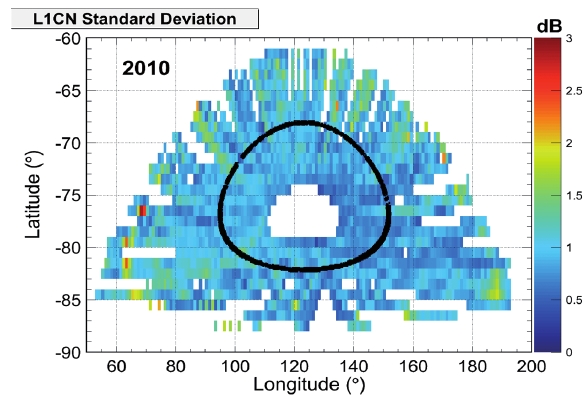
Figure 6. Map of the L1C/N SD in geographic coordinates for 2010. The black curve represents the IPP of the satellite signals with ele- vation angles of